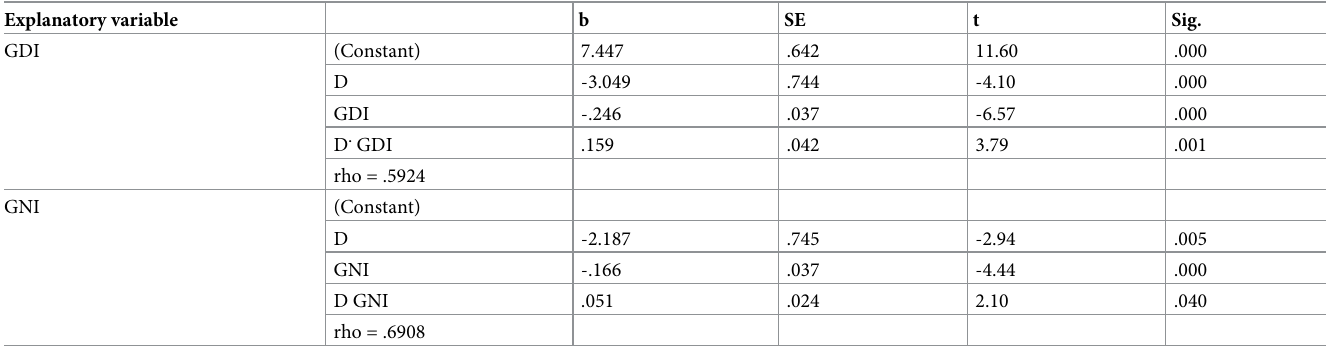
Table 3. Robustness check: Panel regression results. Explanatory